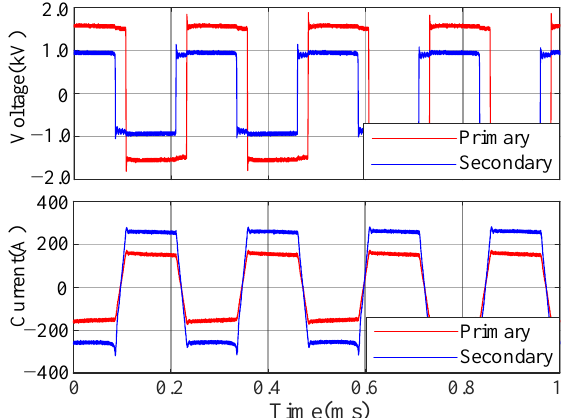
Figure 26. Voltage and current waveforms of the load condition.